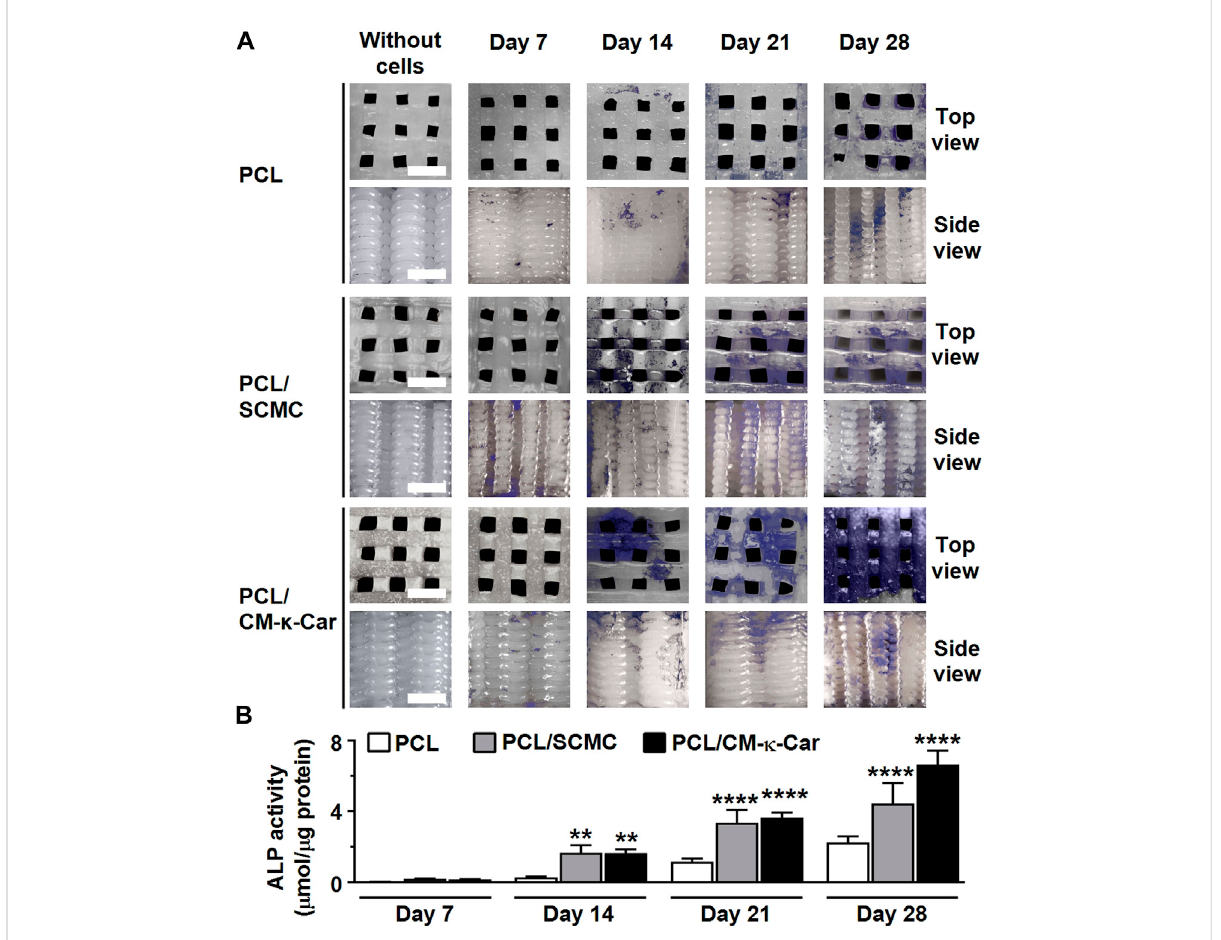
FIGURE 7 Effect of 3D-printed PCL scaffold surface-functionalization by SCMC or CM- κ -Car on ALP activity of MC3T3-E1 pre-osteoblasts after 7, 14, 21, and28 days. (A) ALPstaining(purple).Scalebar:1.5 mm. (B) Quanti fi cationofALPactivity.Valuesaremean±SD( n =3).**Signi fi